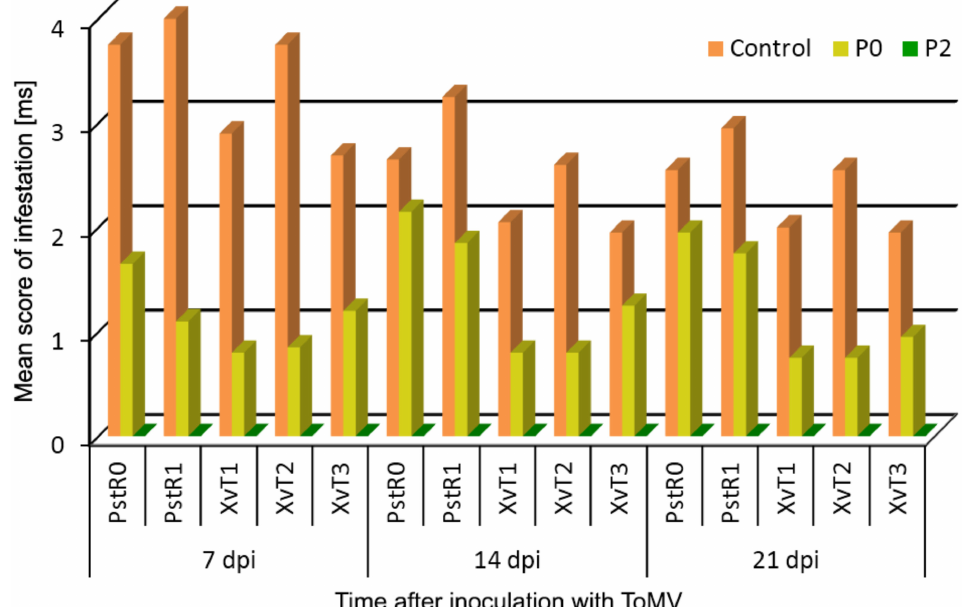
Figure 2. Mean score of infestation from Pst (R0, R1) and Xv (T1, T2, T3) of tomato plants cv. Moperou pre-inoculated with ToMV incompatible strain (GM-0) P0 and with compatible (J) strain P2 (7, 14, and 21